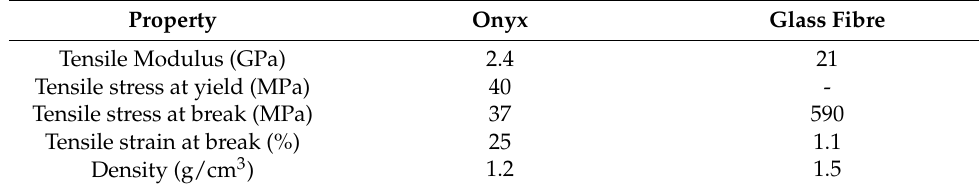
Table 1. Properties of the Onyx and of continuous glass fibre supplied by Markforged [27]. Property